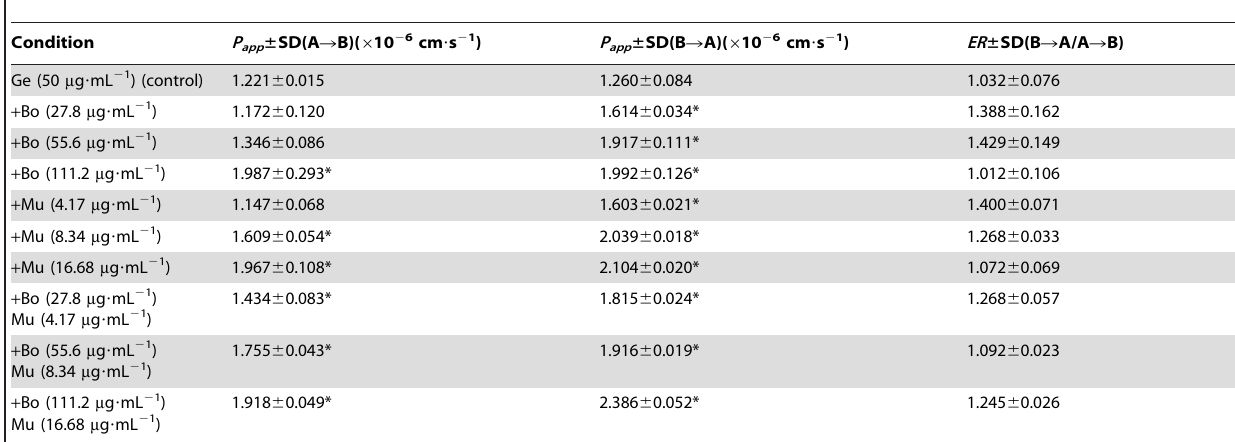
Table 2. Effects of borneol (Bo) and muscone (Mu) on geniposide (Ge) transport in the HNEC monolayer.